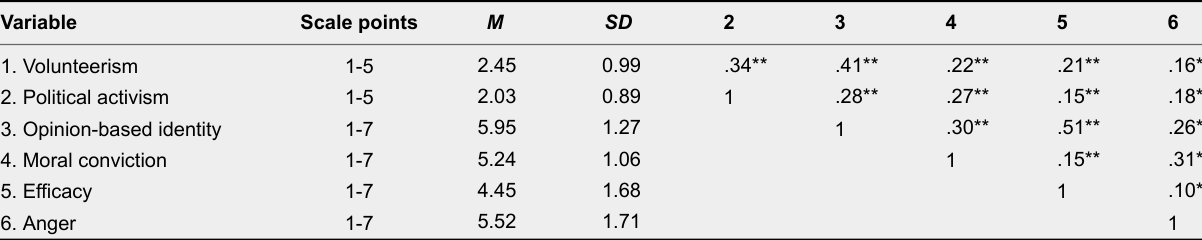
Means, Standard Deviations and Correlations for All